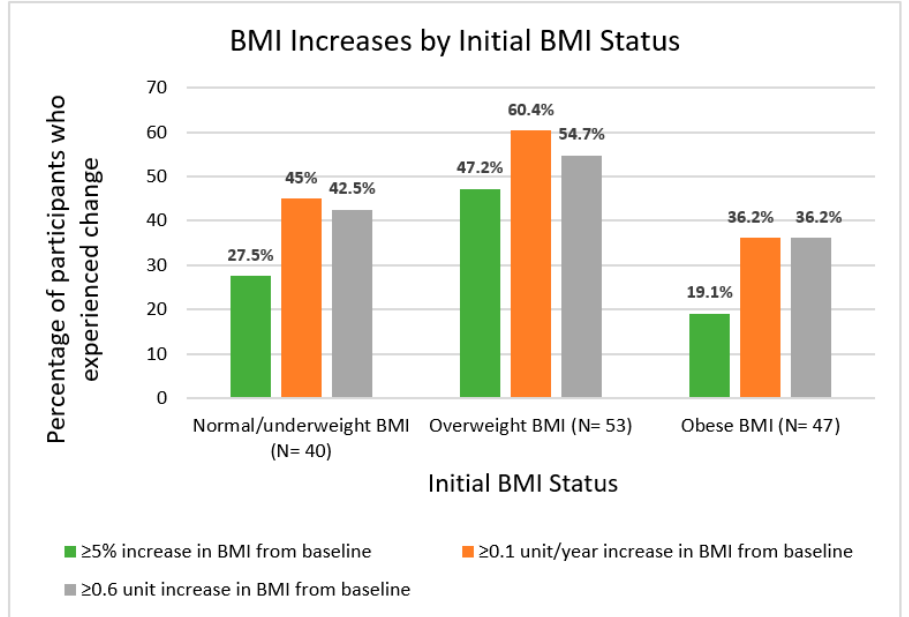
Figure 4. Proportion of percent and unit increases in BMI in kg/m 2 from date of diagnosis to most recent follow-up by BMI group.